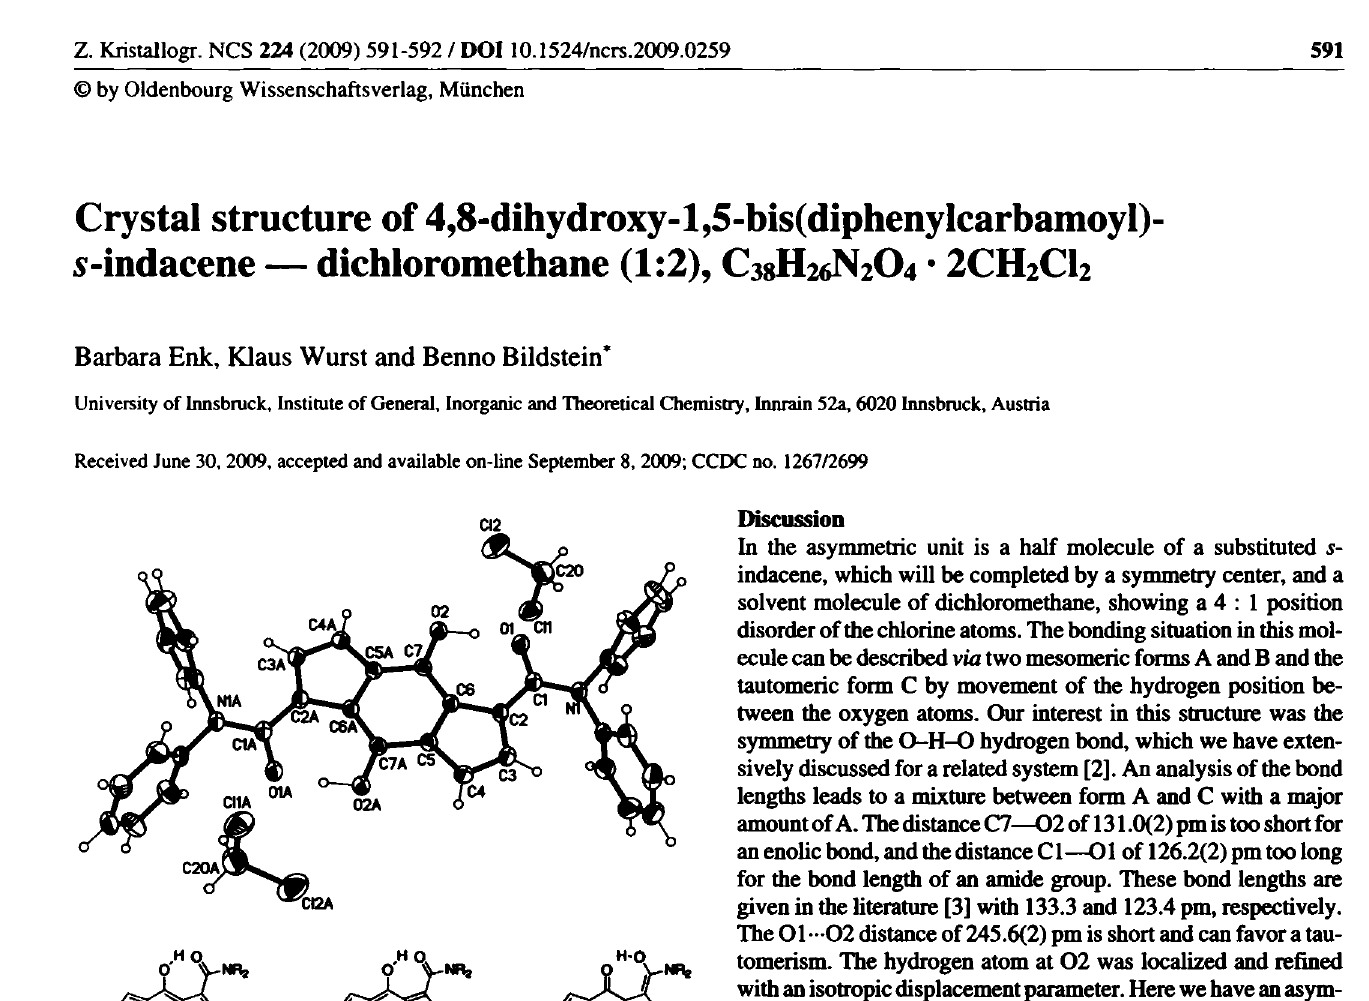
Table 1. Data collection and handling.